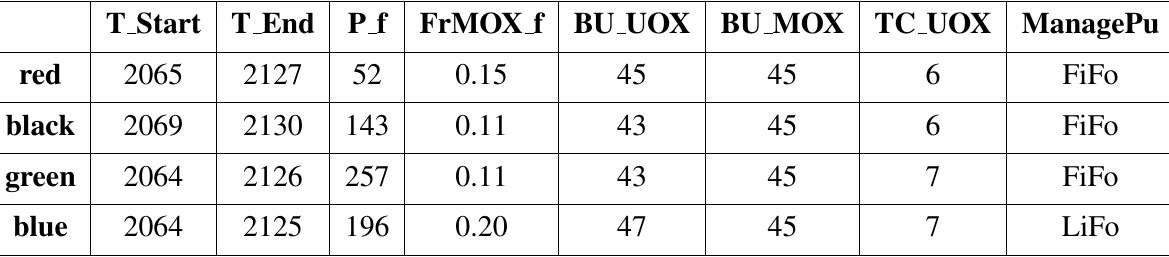
Table 2: Representative Reference Trajectories from clustering on INC